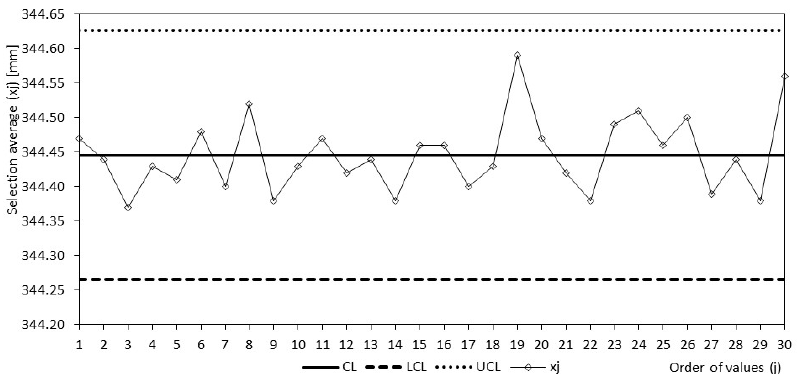
Figure 19. Shewhart control chart for individual values for the length parameter, second day.